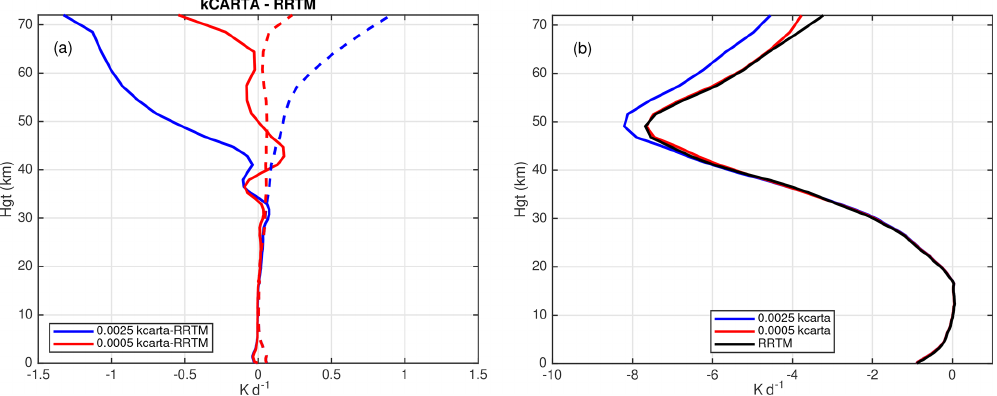
Figure 5. Heating rates for the 630–1180cm − 1 region computed using low-resolution (0.0025cm − 1 ; blue curves) and high-resolution (0.0005cm − 1 ; red curves) kCARTA databases for 49 Earth-spanning atmosphere profiles, compared to RRTM-LW. Panel (a) shows differ- ences in the heating rates, while (b) shows the mean heating